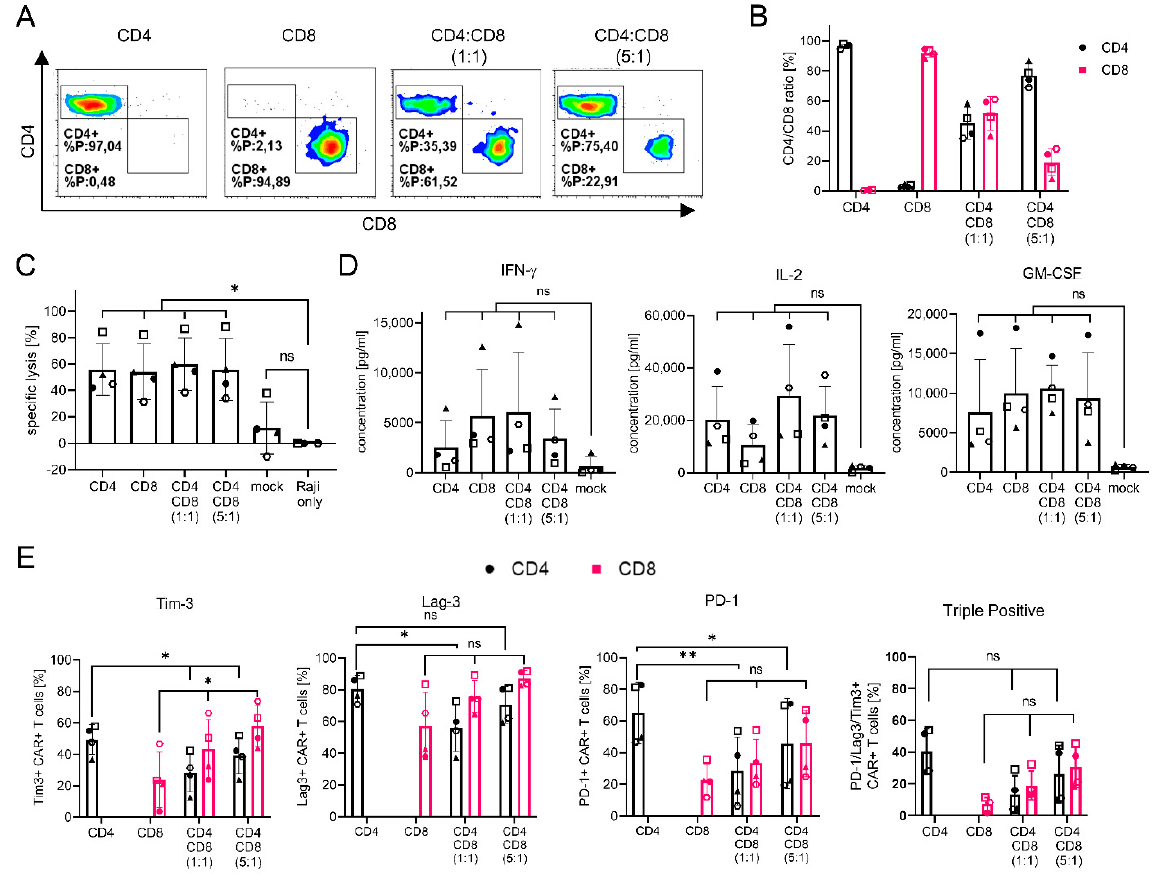
Figure 7. Generation of CD20-CAR-T cells with Ad-LVs. CAR-T cells were generated from activated Pan T cells using Ad-LV (0.5 TU/cell). To generate CAR-T cells with varying CD4/CD8 ratios, either LLE-CD4 f(ab) 2 or LLE-CD8 f(ab) 2 adapters alone or a mixture of both adapters in 1:1 or 1:5 ratio was used. ( A ) Representative data of T cells transduced with Ad-LVs using LLE-CD4 f(ab) 2 (clone: MT-466) or LLE-CD8 f(ab) 2 (clone: BW135/80) alone or in a mixture are shown. ( B ) The CD4/CD8 ratio of the CAR-T cells is shown. To analyze if the generated CAR-T cells are functional co-cultures with CD20, + GFP+ Raji cells were set up in an E:T ratio of 1:1. ( C ) Specific lysis of target cells was analyzed via flow cytometry 24 h post setup of the co-culture. ( D ) Secretion of specific cytokines was analyzed using the MACS Plex Assay Kit. ( E ) Activation/exhaustion marker expression was analyzed 6 days post setup of the co-culture assay. Data are represented as mean ± SD of 4 different donors. Statistics: repeated measure one-way ANOVA using Dunnett’s or Tukey’s multiple comparison test; ns = non-significant * p < 0.05, ** p < 0.01.